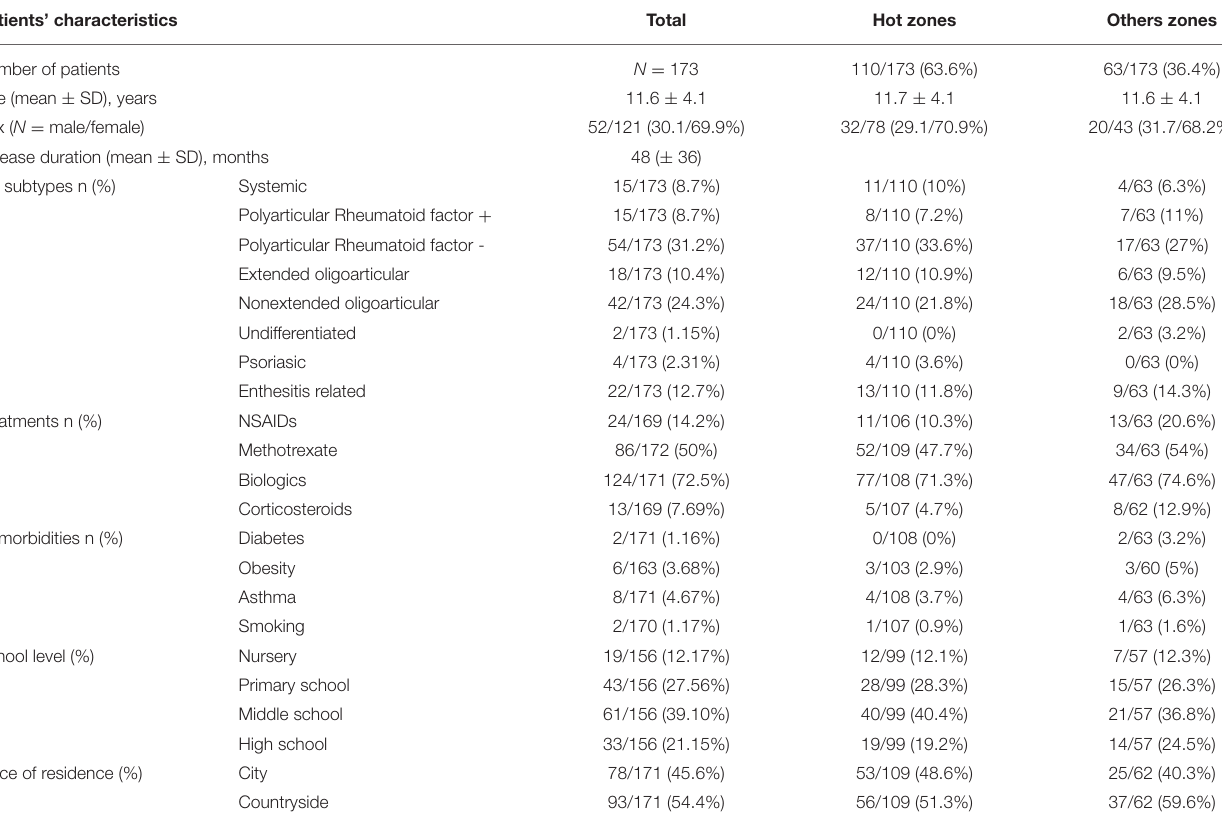
TABLE 1 | Patients characteristics at inclusion.